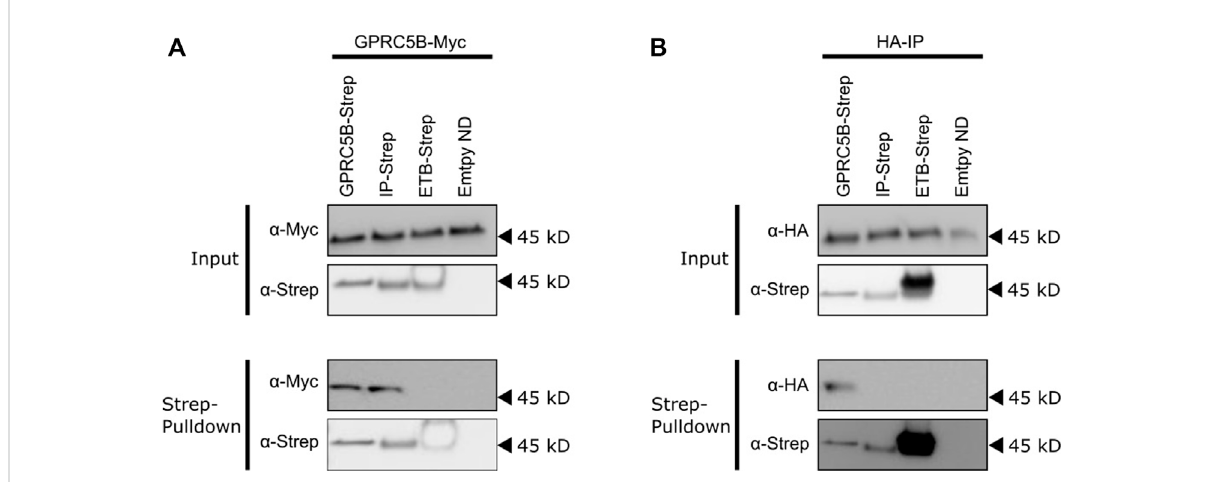
FIGURE 13 InteractionsoftransferredandtransfectedGPCRs.HEK293TcellsweretransfectedwithconstructsexpressingeitherGPRC5B-Myc (A) orHA-IP (B) .After24 h,thetransfectedcellswereincubatedwith0.5 µMofeitherGPRC5B/NDs,IP/NDs,ETB/NDsoremptyNDsfor16 htoallowef fi cientMP transfer. The cells were then washed, lysed and pulldowns based on the Strep-tags of the transferred GPCRs were performed. The MPs were subsequently analyzed for co-puri fi cation by SDS-PAGE and immunoblotting. (A) Analysis of transfected cells synthesizing GPRC5B-Myc. Upper panel input: Immunoblotting of cell lysates showing successful expression of GPRC5B-Myc ( α -Myc) and the successful transfer of either GPRC5B, IP or ETB ( α -Strep). Lower panel Strep-pulldown: Immunoblotting of the eluate from the Strep-column detecting transferred GPCRs ( α - Strep) and co-puri fi ed transfected GPRC5B-Myc ( α -Myc). No pulldown of GPRC5B-Myc was observed with transferred ETB or empty NDs. (B) Analysis of transfected cells synthesizing HA-IP. Upper panel input: Immunoblotting of cell lysates with anti-HA antibody shows a successful expression of HA-IP ( α -HA) and the successful transfer of either GPRC5B, IP, or ETB into the cells ( α -Strep). Lower panel Strep-pulldown: Immunoblotting of the eluate from the Strep-column detecting transferred GPCRs ( α -Strep) and co-puri fi ed transfected HA-IP ( α